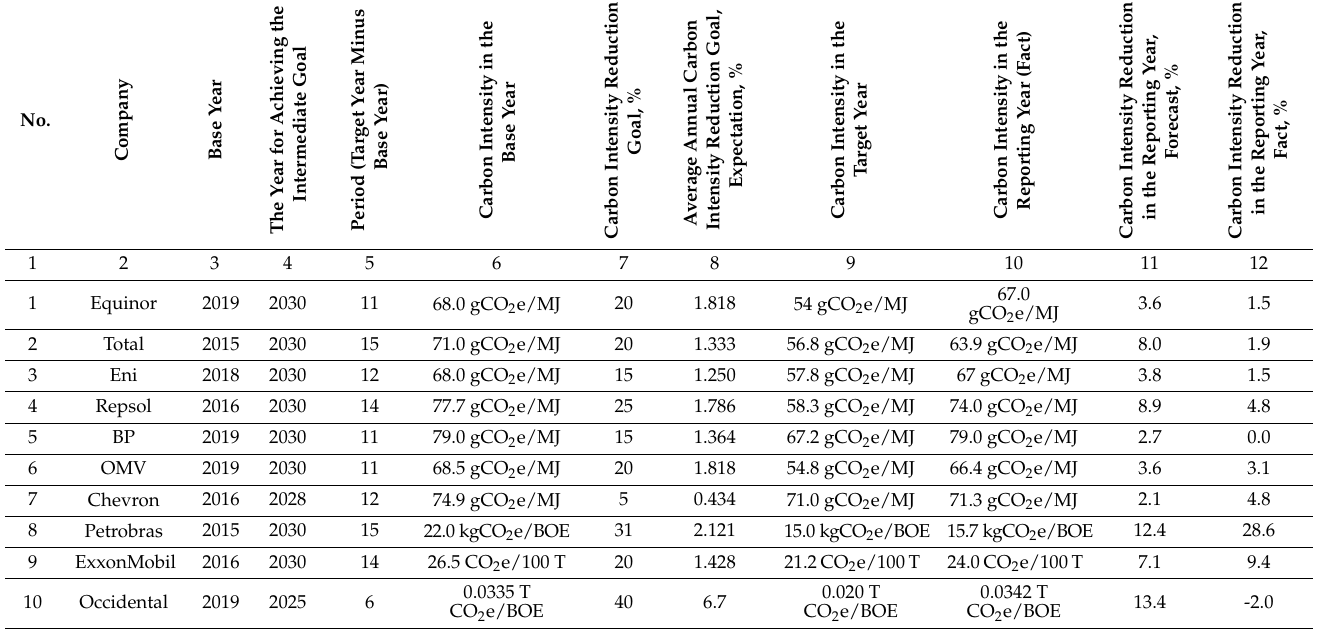
Table 3. A comparative analysis of carbon intensity indicators and an assessment of trends related to achieving the intermediate goals of oil and gas companies on the way to carbon